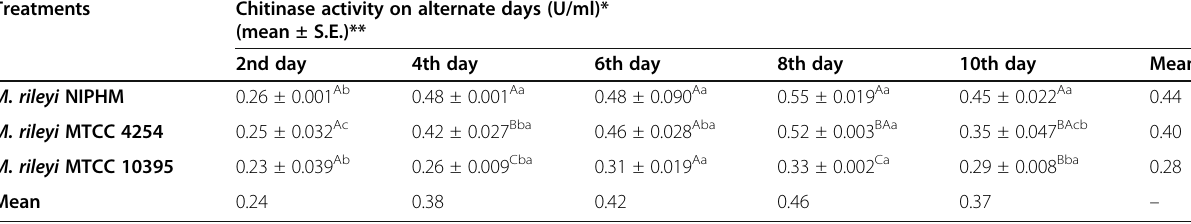
Table 2 Chitinase activity of Metarhizium rileyi isolates on different days after inoculation Treatments